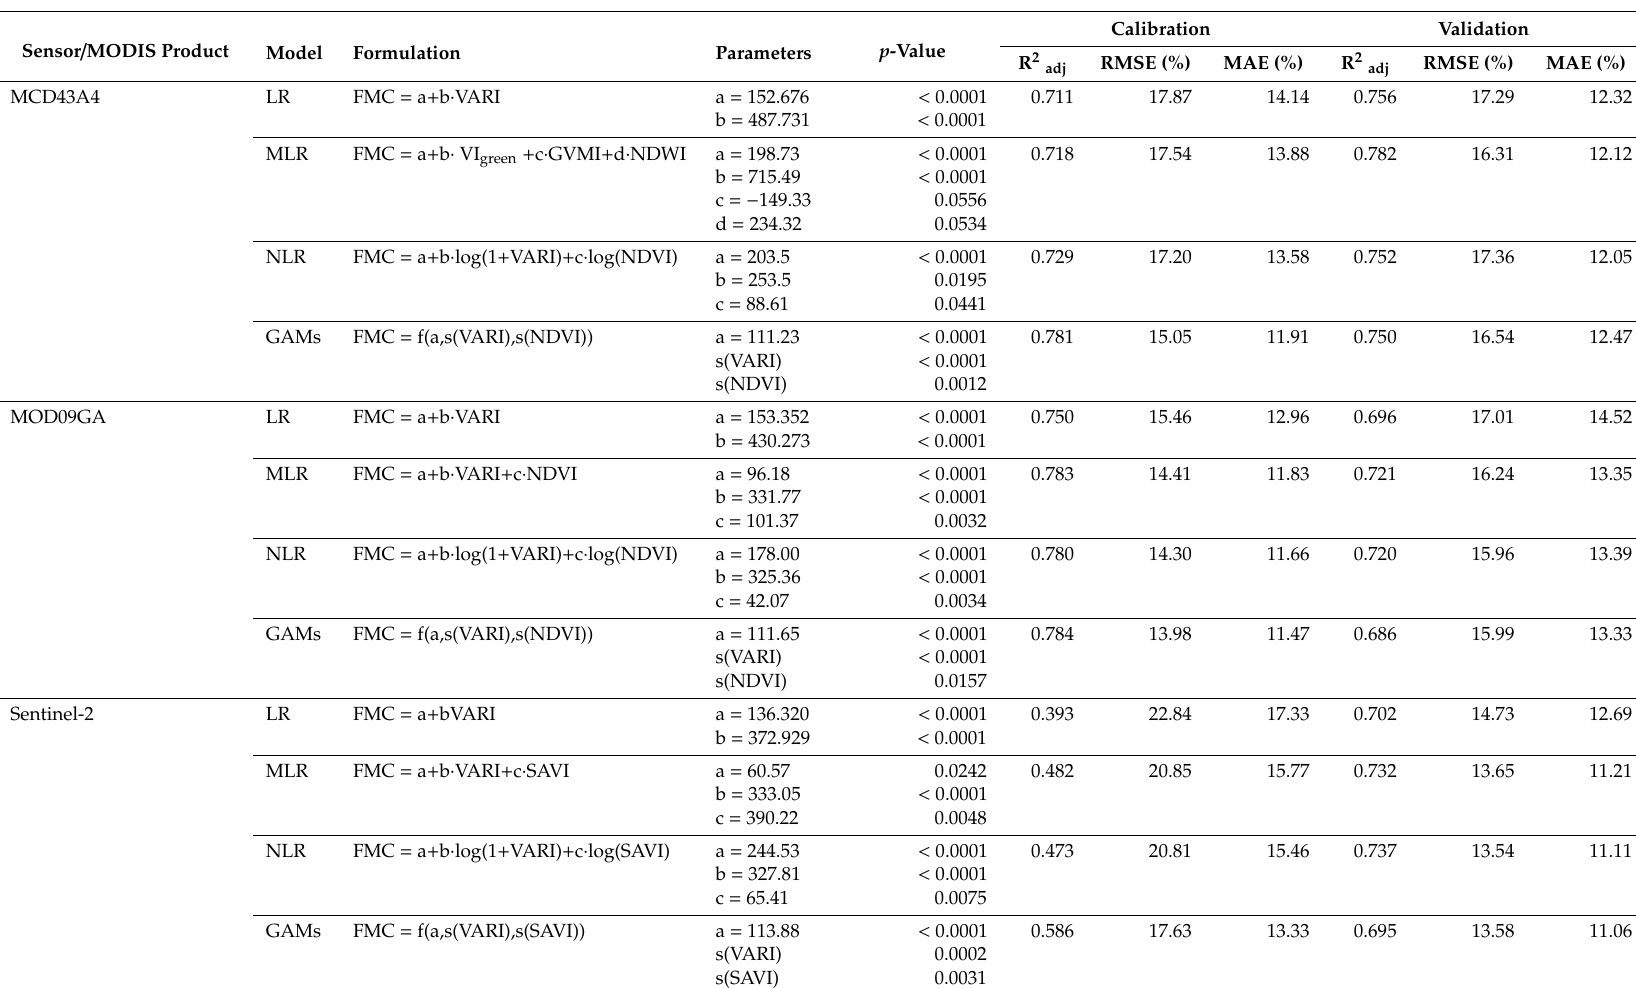
Table 5. Best empirical models fitted for each sensor, MODIS product, and method used. R 2 adj , adjusted R 2 ; MAE, mean absolute error; RMSE, root mean square error. Sensor / MODIS